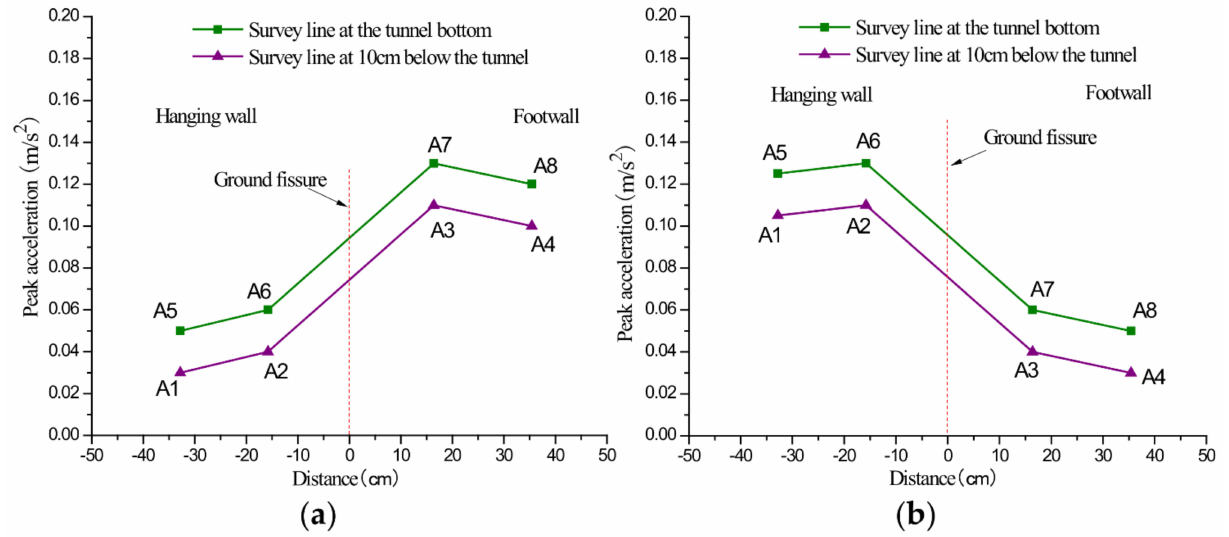
Figure 13. Peak acceleration curves under the combined impact of inactive ground fissure and 10 Hz excitation: ( a ) vibration exciter at 60 cm; ( b ) vibration exciter at 100 cm.